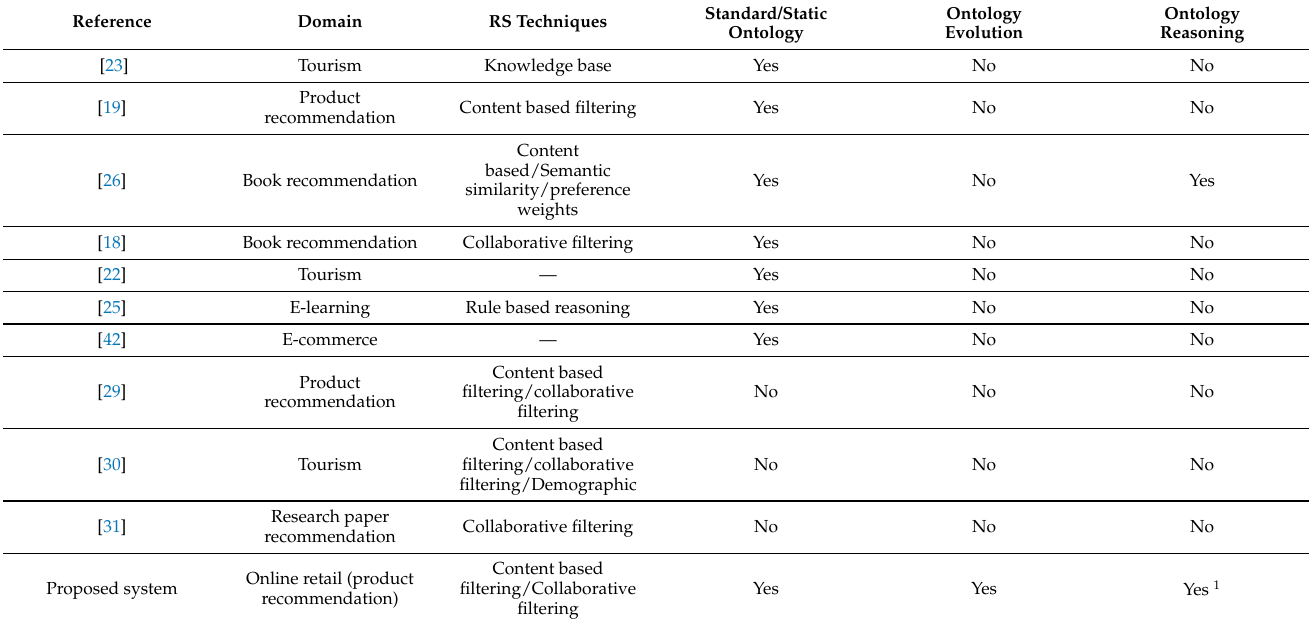
Table 3. Qualitative comparison to other hybrid